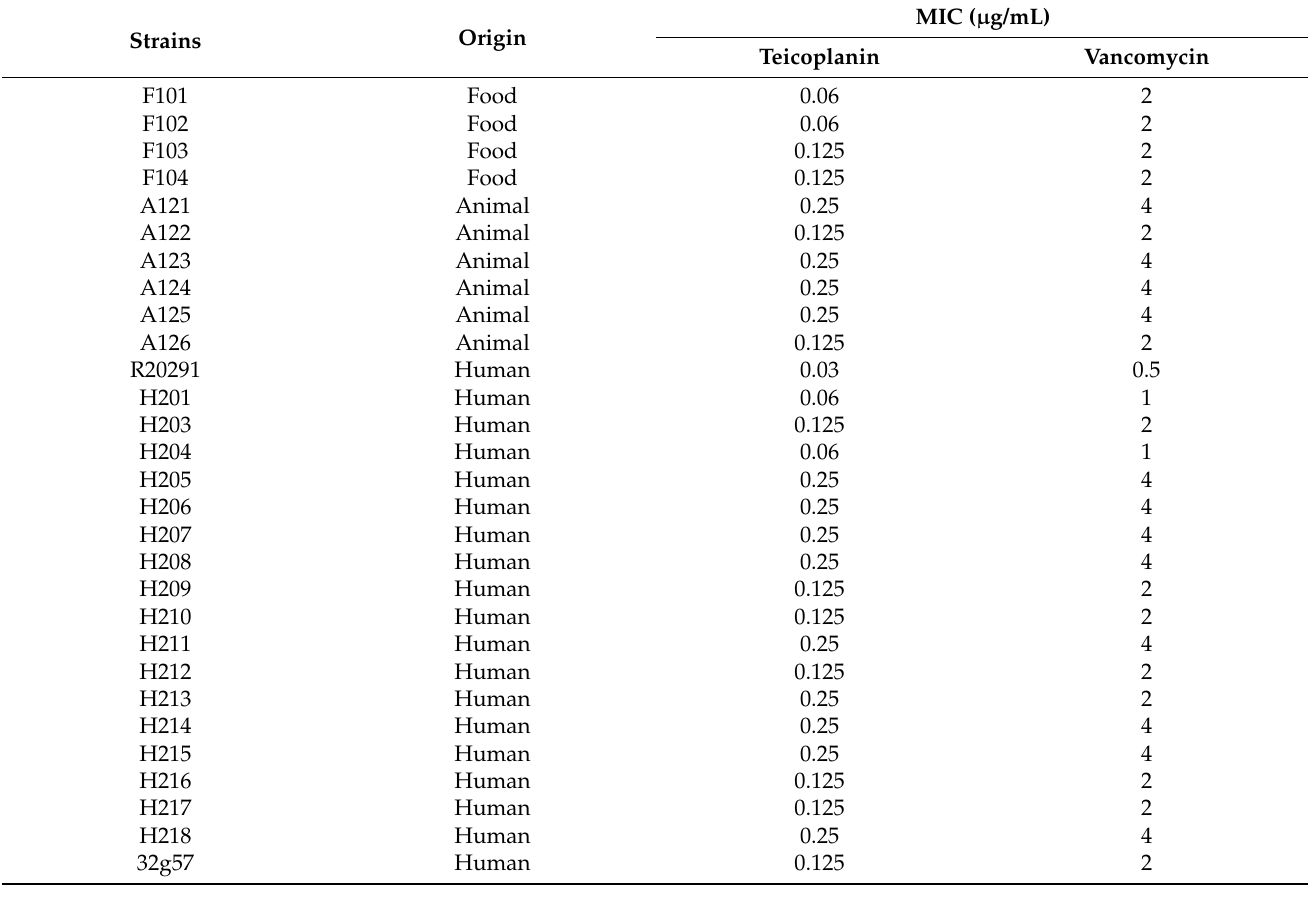
Table 1. Minimal inhibitory concentrations for teicoplanin and vancomycin for 30 C. difficile strains.